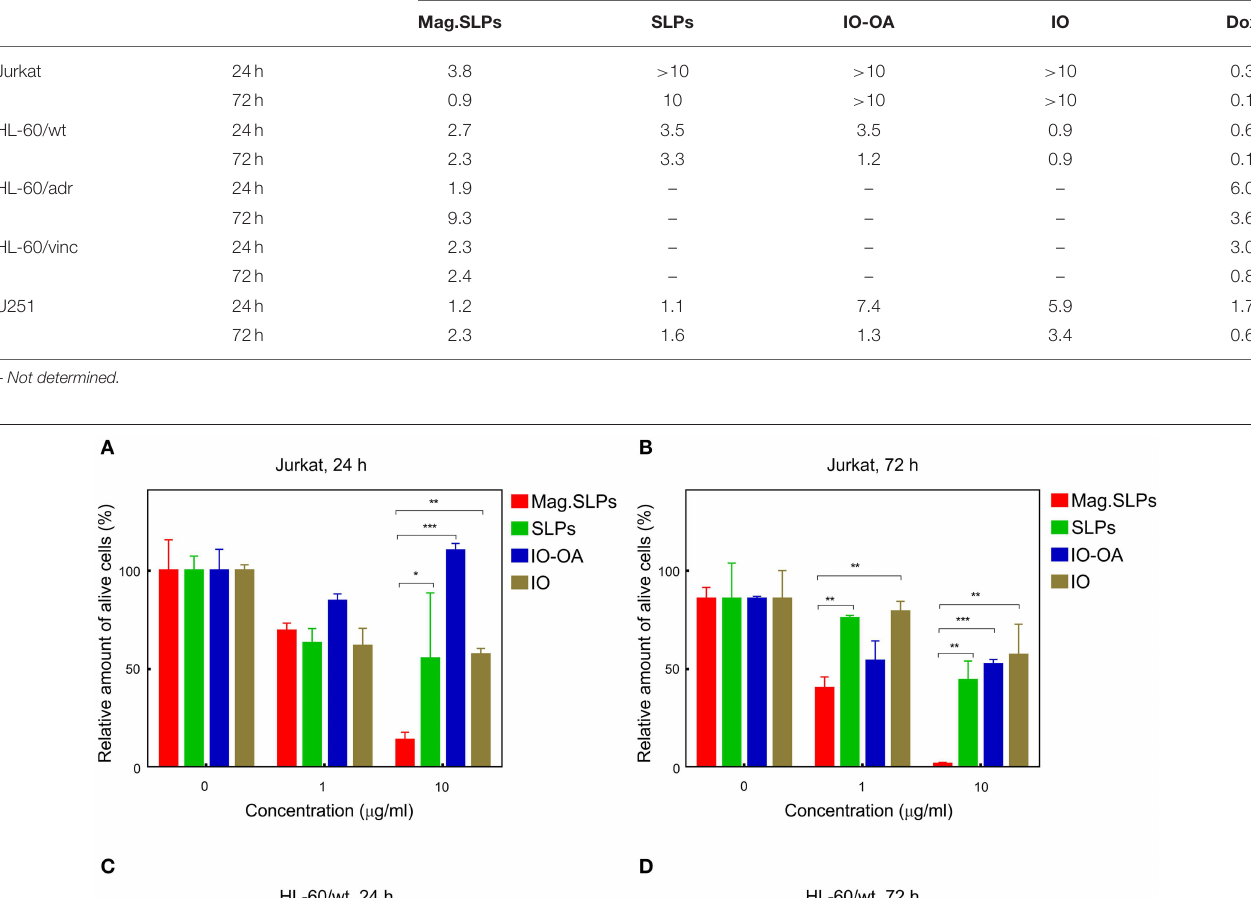
concentrations, i.e., 1 and 5 µ g of the particles/ml, especially for the mag.SLPs ( Figure 6A ). In contrast, upregulated DHE fluorescence, attributed to growing O 2 − concentration, was found only for the mag.SLPs at a high concentration ( Figure 6B ). H 2 O 2 and O 2 − levels in the mag.SLPs-treated human leukemia cells of Jurkat line were increased by ∼ 20–40 and ∼ 70%,